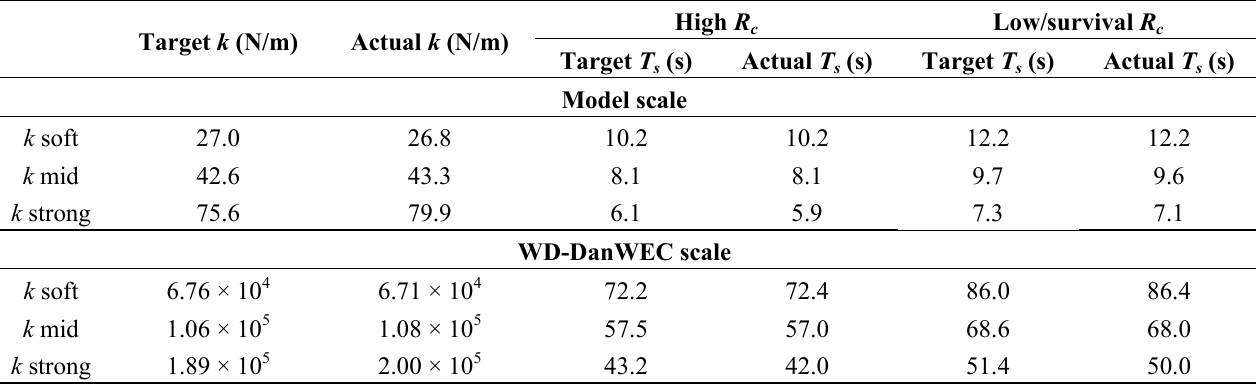
(s) is the surge natural period. s High R Low/survival R c